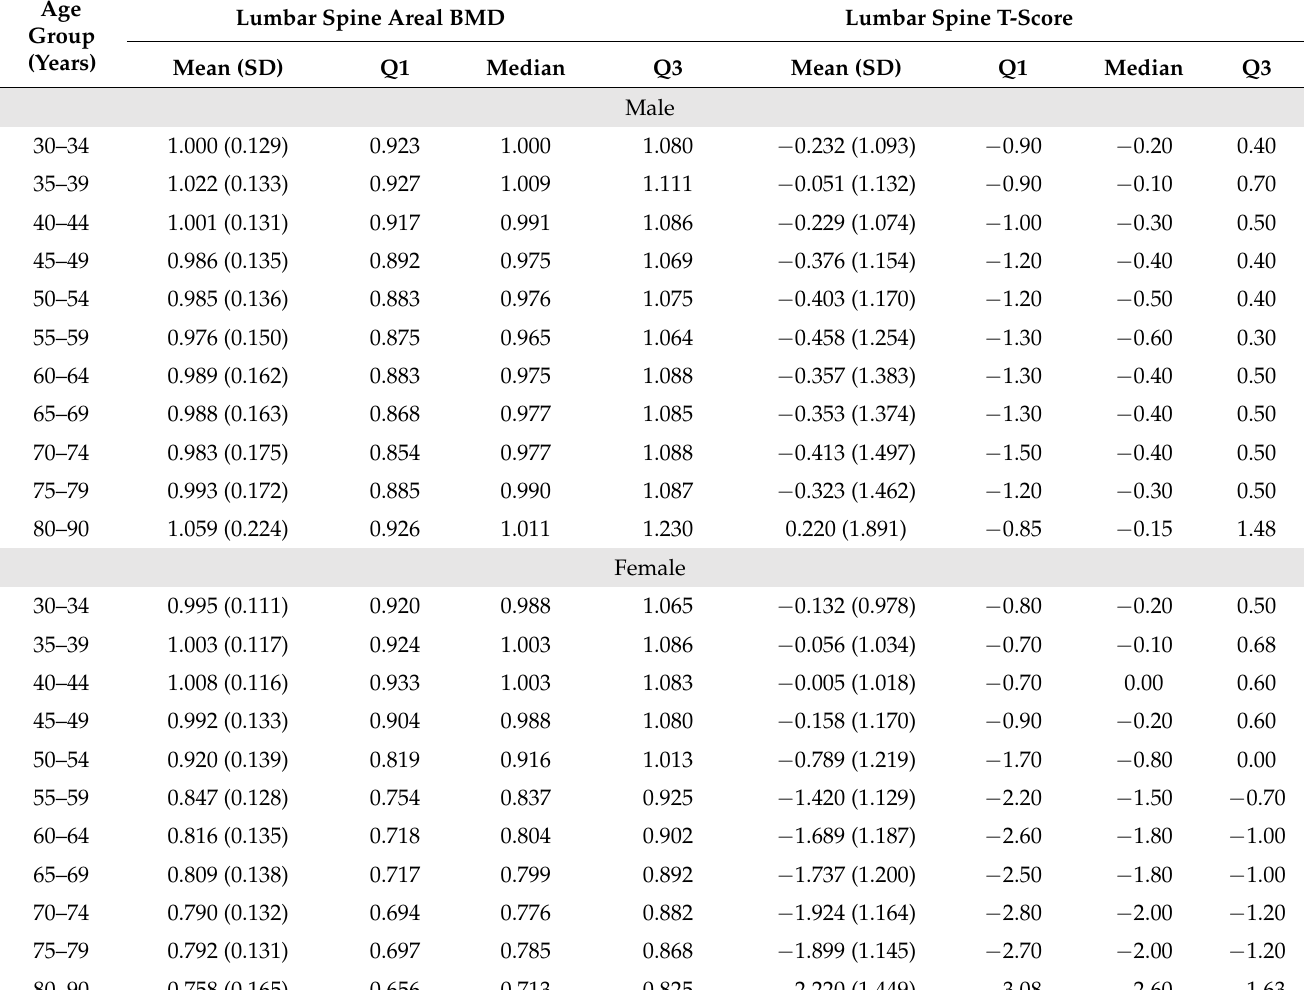
Table 2. Age-specific lumbar spine areal bone mineral density for Taiwanese men and